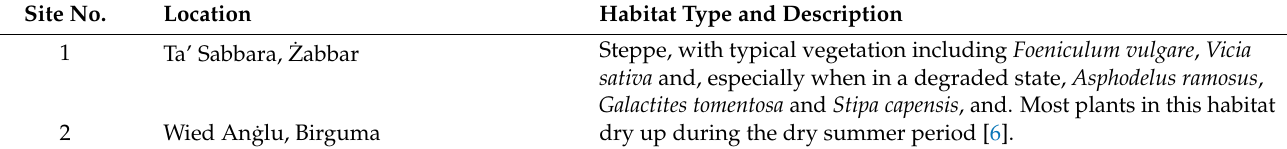
Figure 1. Map of the Maltese Islands (Gozo and Malta) showing the locations where data were collected between 2015–2022 (with names, habitat description and predominant vegetation of locations indicated in Table 1). Table 1. Locations where data were collected for this study: habitat type and brief description. Site No.